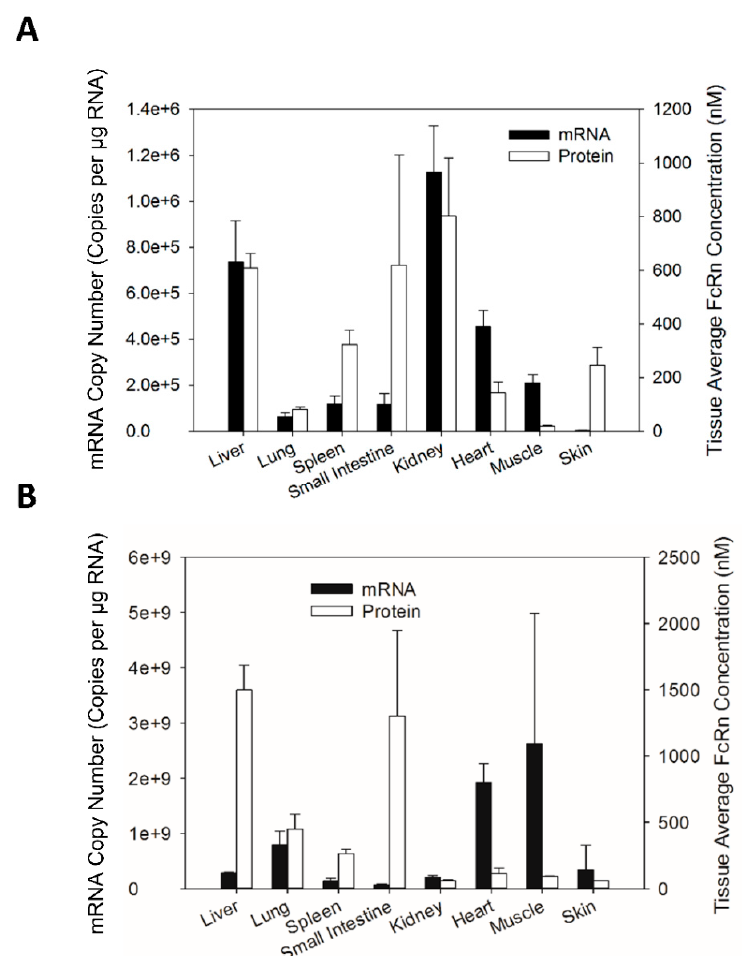
Figure 4. Comparison of tissue mFcRn mRNA and protein expression pattern in Swiss Webster mice ( A ) and comparison of tissue hFcRn mRNA and protein expression pattern in transgenic mice. ( B ) Data are mean ± SD from 5 Swiss Webster mice and 3 transgenic mice.